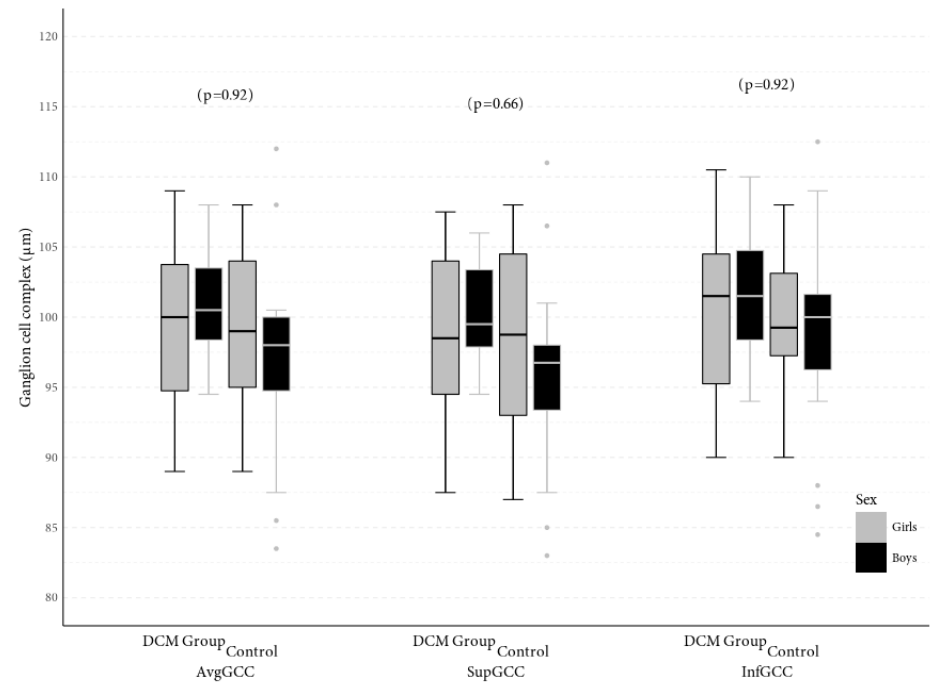
Figure 3. Central tendency and dispersion for GCC ( μ m) at selected anatomical locations in the study sample by DCM status and sex.